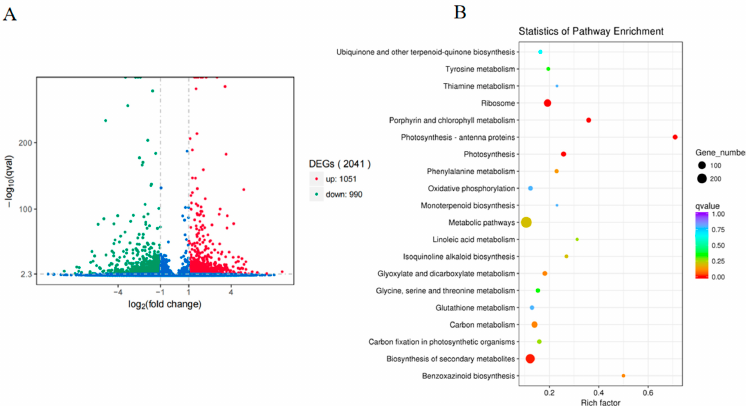
Figure 1. DEGs number and KEGG pathway enrichment with EBL treatment in RNA-seq. ( A ) Volcano plot with DEGs number. ( B ) KEGG pathway scatterplot, rich factor, the ratio of the number of differential genes in the metabolic pathway to the number of all genes annotated to the pathway. 2.2. The Impact of EBL on C4-NADP-ME Expression in Maize Leaves Previous experiments have shown that exogenous spraying of EBL promotes the transcription of dark reaction enzymes [23]. We found that the expression of ZmC4 NADP- ME following EBL treatment was upregulated in RNA-seq (Figure 2A). To further study how EBL regulates ZmC4 NADP-ME expression, different concentrations of EBL were used to spray maize seedlings or whole plants in the field. The results showed that the expression of the ZmC4 NADP-ME gene significantly increased by 1.8 times on the 5th day after 150 nmol/L EBL in the field. On the 10th day after treatment with 100 nmol/L EBL, the expression of the gene increased by approximately seven times. The expression of ZmC4 NADP-ME in the leaves of maize seedlings increased significantly by 8.6 times after 24 h EBL treatment (Figure 2B). These results show that EBL can promote the expres- sion of C4-NADP-ME in maize leaves.